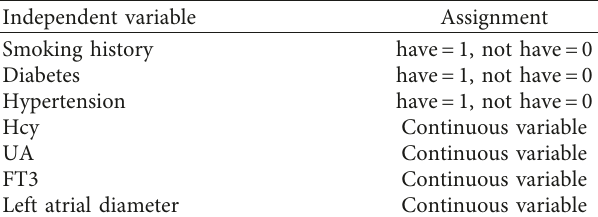
Table 2: Variable assignment.